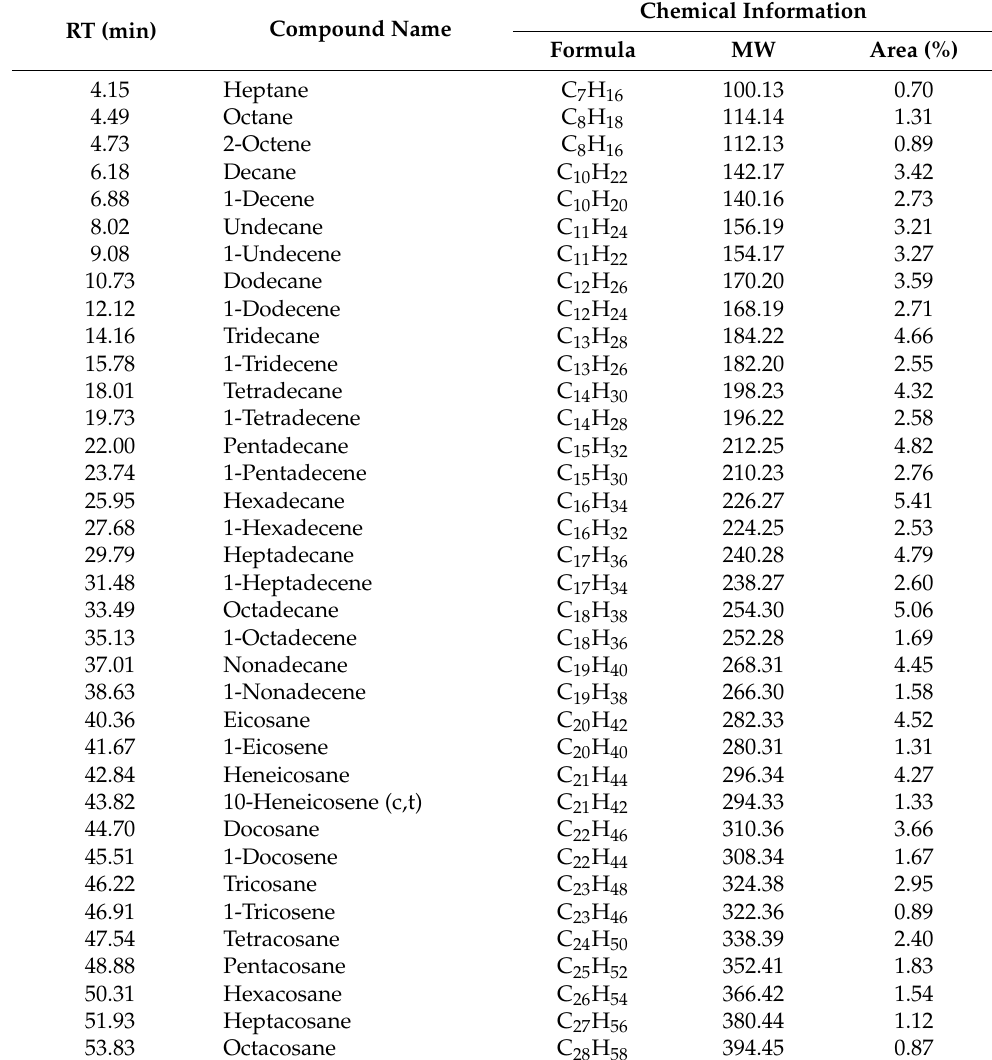
Table 4. The identification and distribution of the compounds for WPBCO.